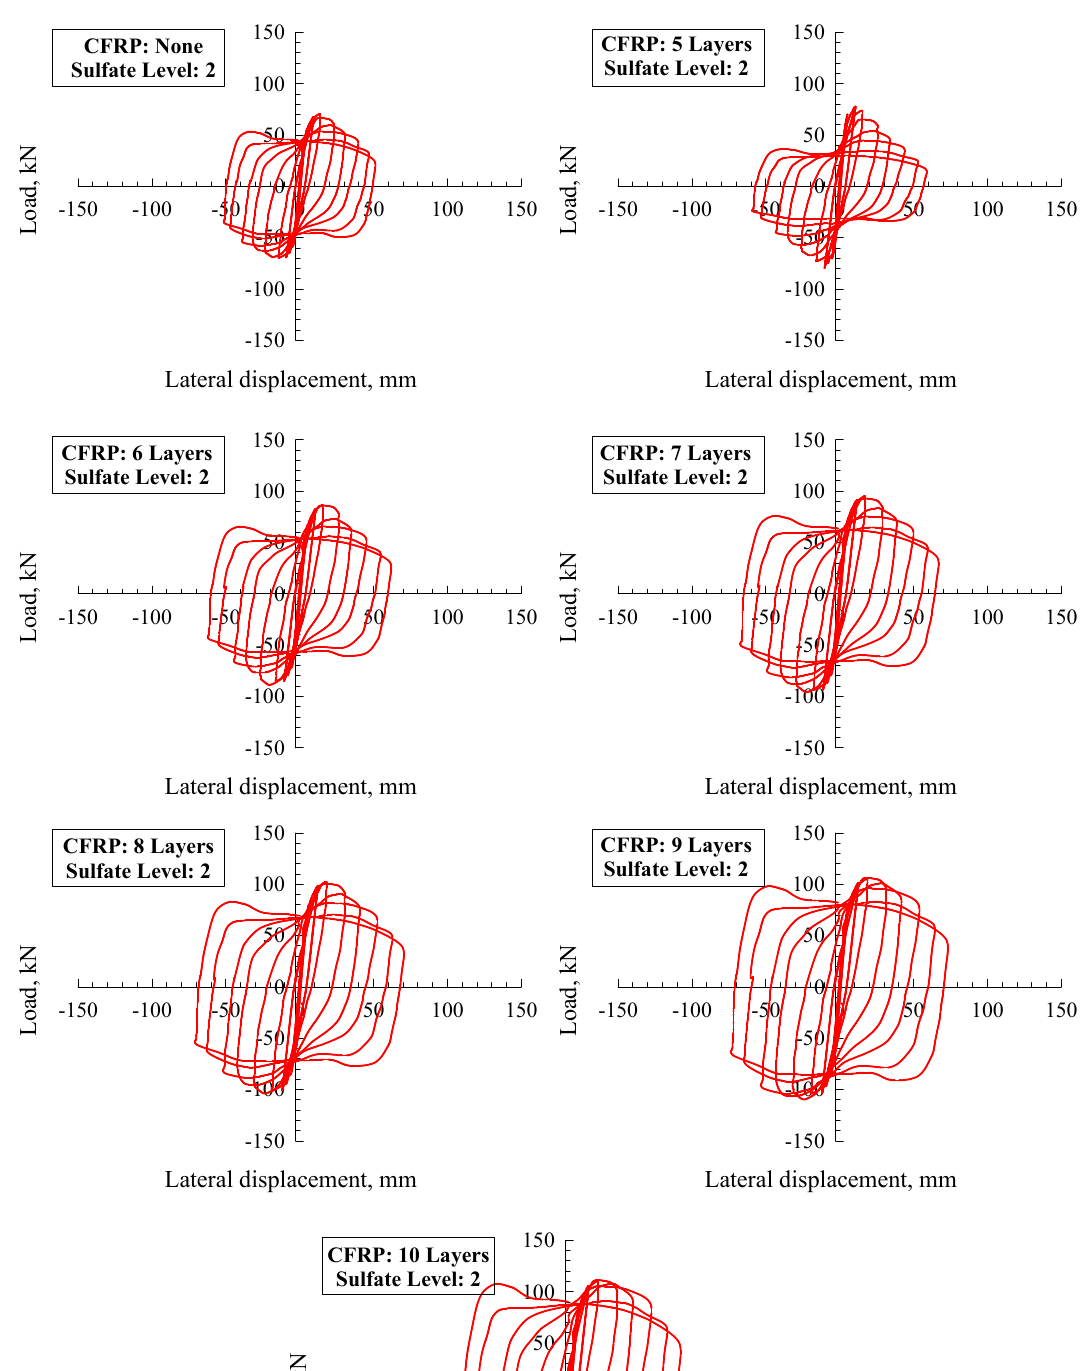
Figure 8. CFT column horizontal load–net drift hysteresis loops for sulfate level 1.